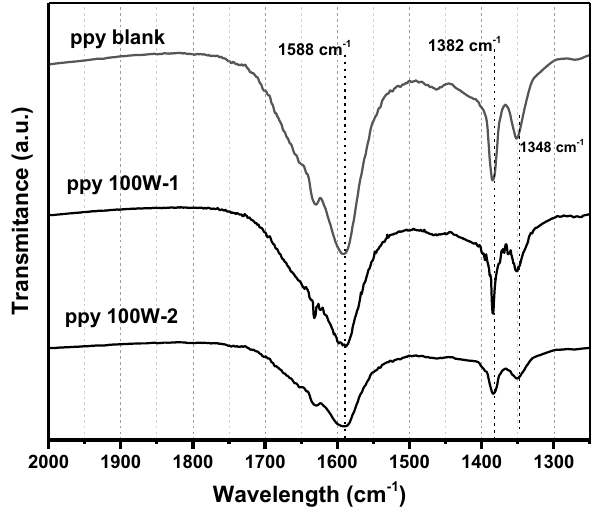
Fig. 2 FT-IR spectra of ppy blank, ppy 100W-1 and ppy